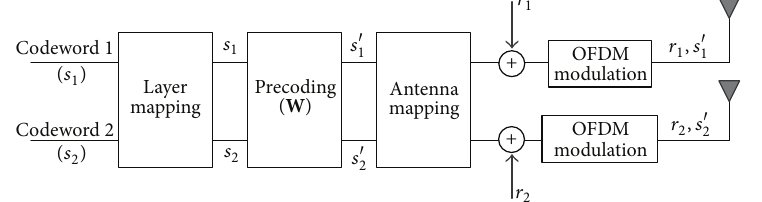
Figure 1: Basic structure of LTE multiantenna transmission ( 2 × 2 antenna configuration).